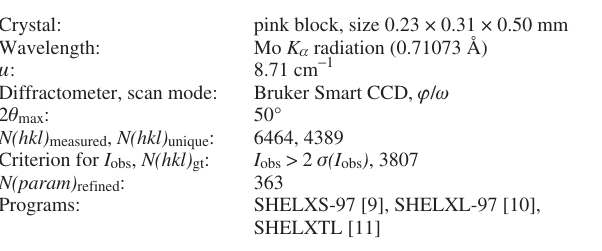
Table 1. Data collection and